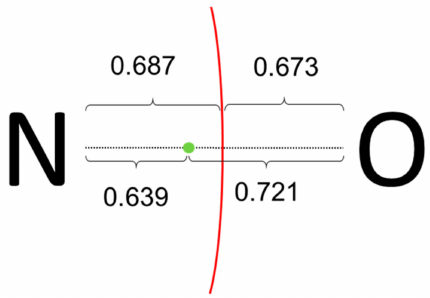
Figure 4. Pictorial representation of the zero-flux surface and position of the centroid of the NLMO σ N-O orbital for (CH3) 3 NO. In the case of PM, the distances from the centroid to N and O are 0.660 and 0.692 (in